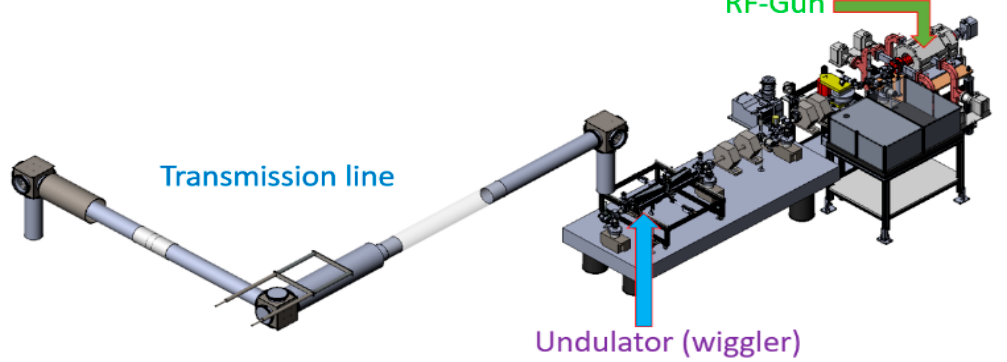
Figure 1. THz FEL setup at the Schlesinger Center.